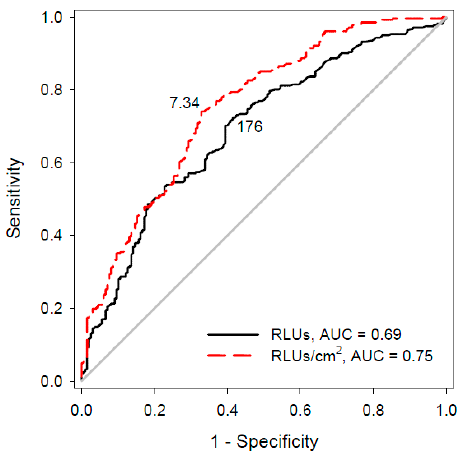
Figure 3. Receiver-operating characteristic (ROC) curves of the criteria based on the non-adjusted ATP-based values (RLU; solid black line) and adjusted ATP-based levels (RLU/cm 2 ; dashed red line) versus the microbial growth-based values. Culture-based levels of >2.5 CFU/cm 2 were regarded as culture positive. The best cut-off points demonstrated by both curves were determined using the Youden index. AUC refers to the area under the